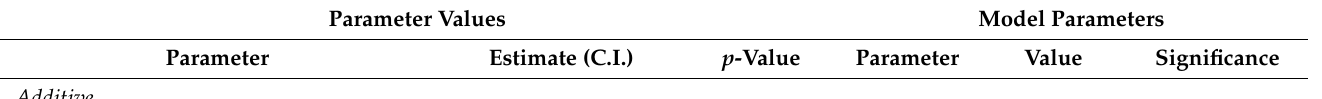
Table 5. Multivariate Geospatial Analysis for Neural Tube